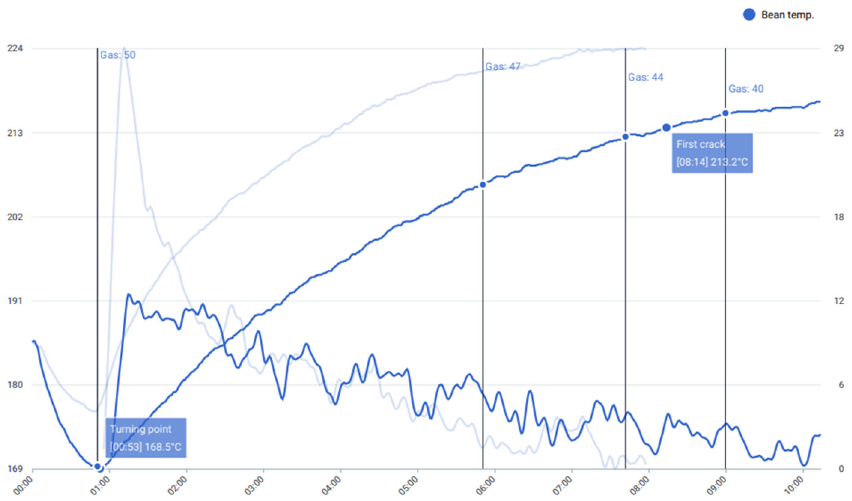
Figure 2. The roasting curves of Peruvian coffee. The green beans were roasted at a final temperature of 215 ◦ C for 10 min, and the development time was 1.5 min. The first crack is the moment when coffee beans start to progress towards an edible state. The time after the first crack is the development time.